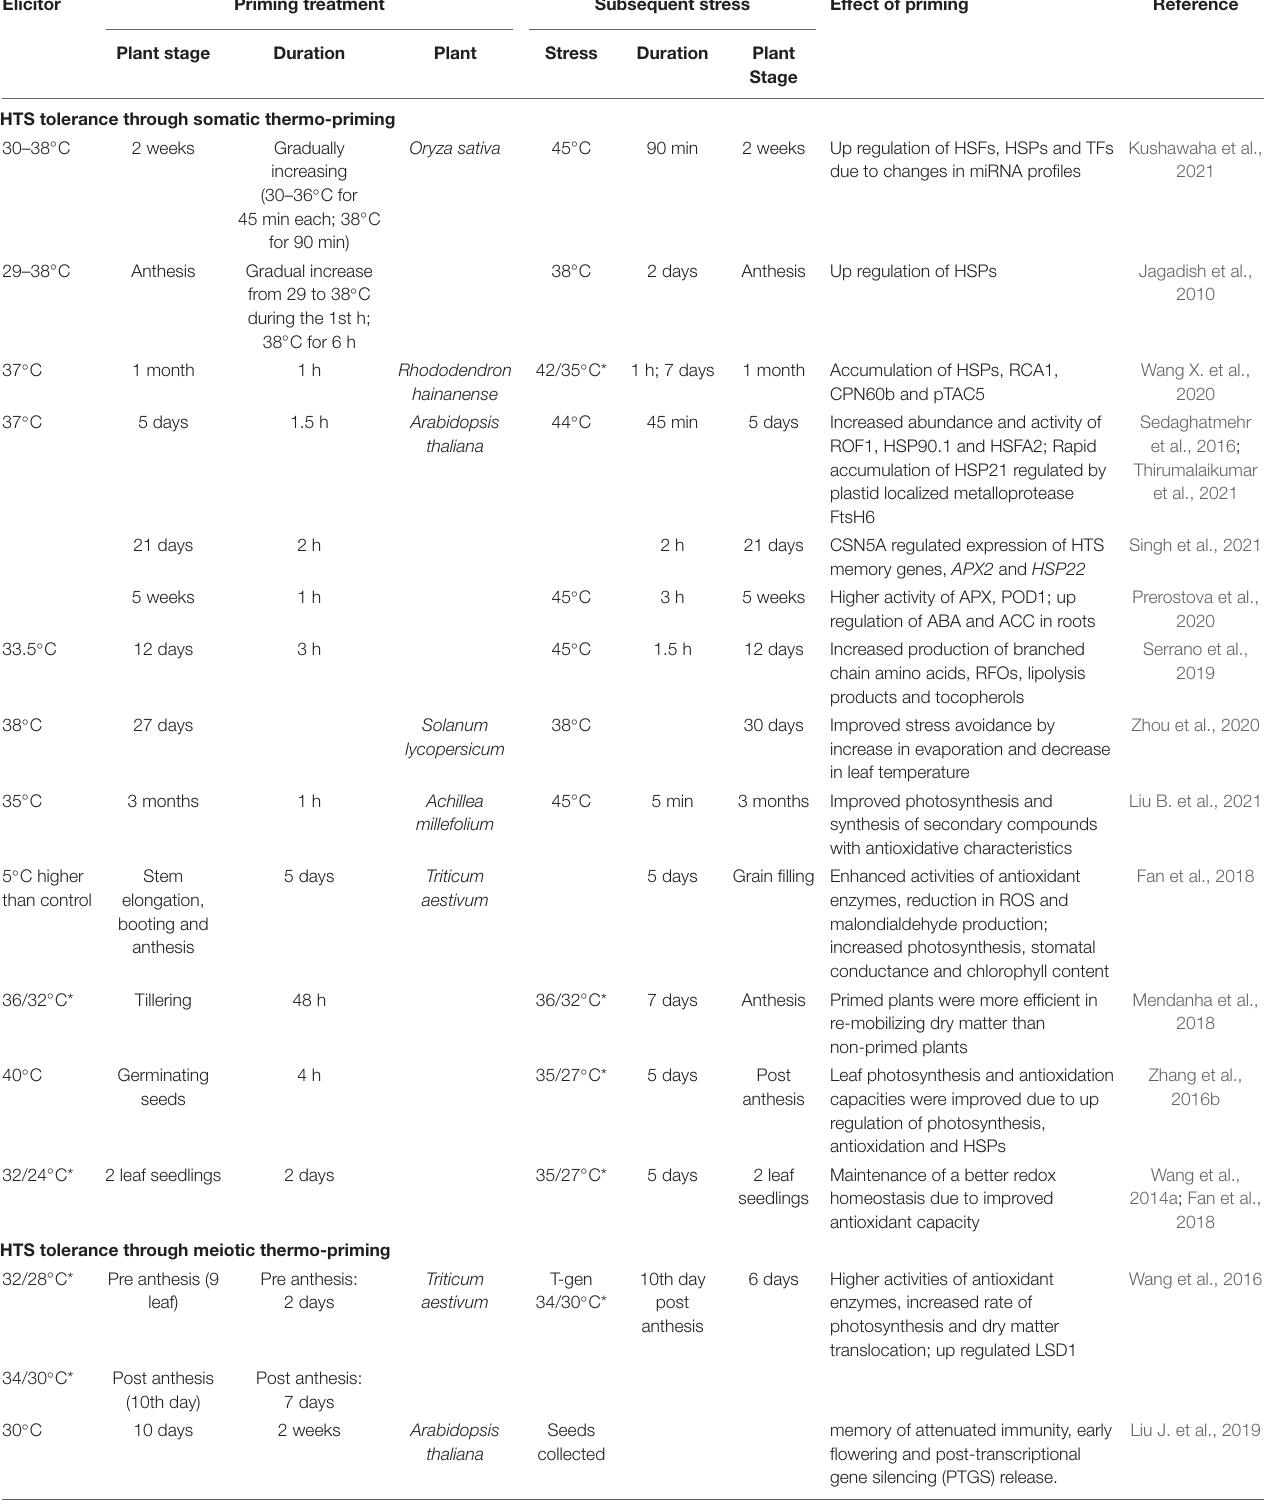
TABLE 1 | Thermo-priming for enhancing plant tolerance to high temperature and other abiotic stresses.